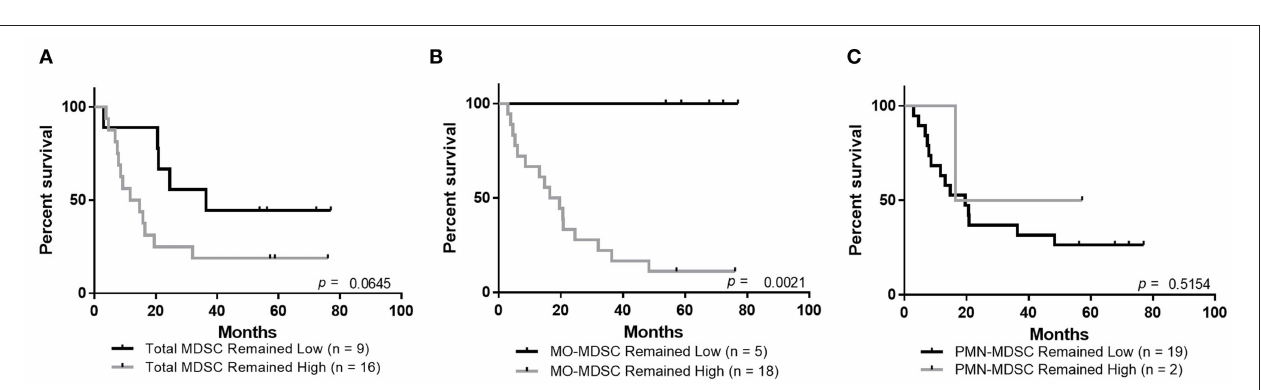
FIGURE 3 | total and CD14( + ) MDSCs was compared in patients with high or low levels of IL-8 and compared using a Pearson correlation test. The overall survival of patients with high or low levels of (E) total, (F) MO-, or (G) PMN-MDSCs was compared using a log-rank test. The cell surface expression of CXCR1 (H) and CXCR2